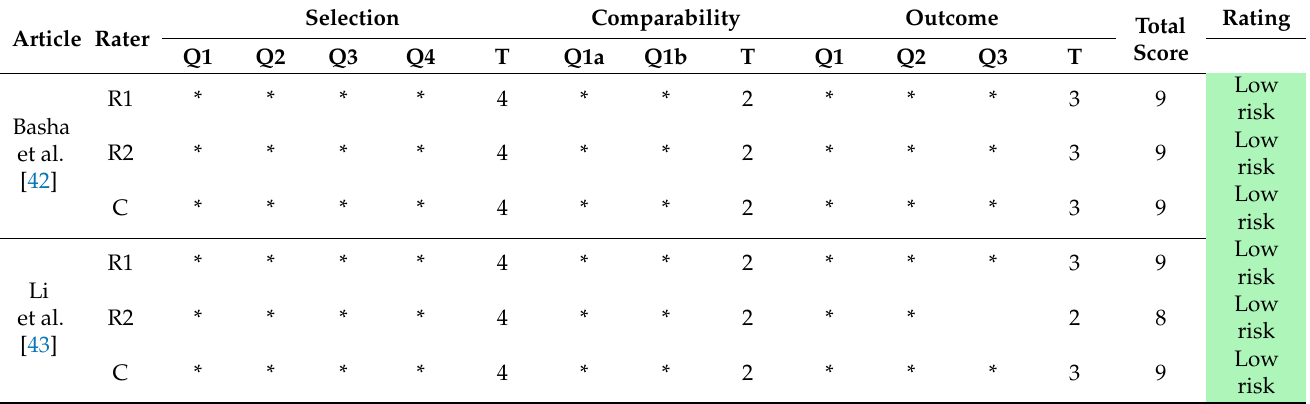
Table 4. Calibration findings using NOS on two cohort studies.